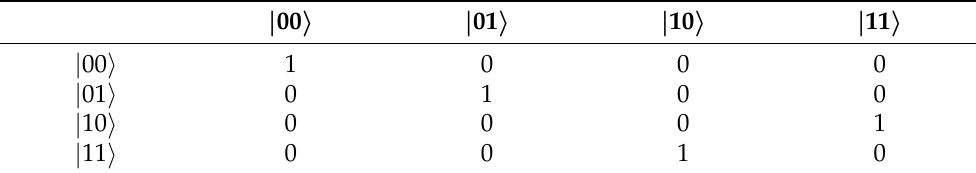
Table 4. Unitary matrix associated to the truth table of the CN operation.